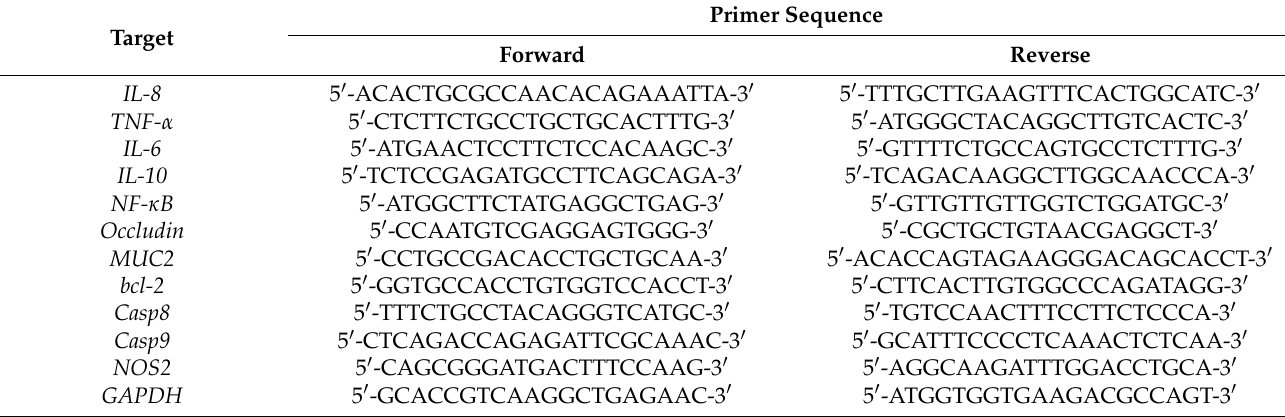
Table 1. List of primers a